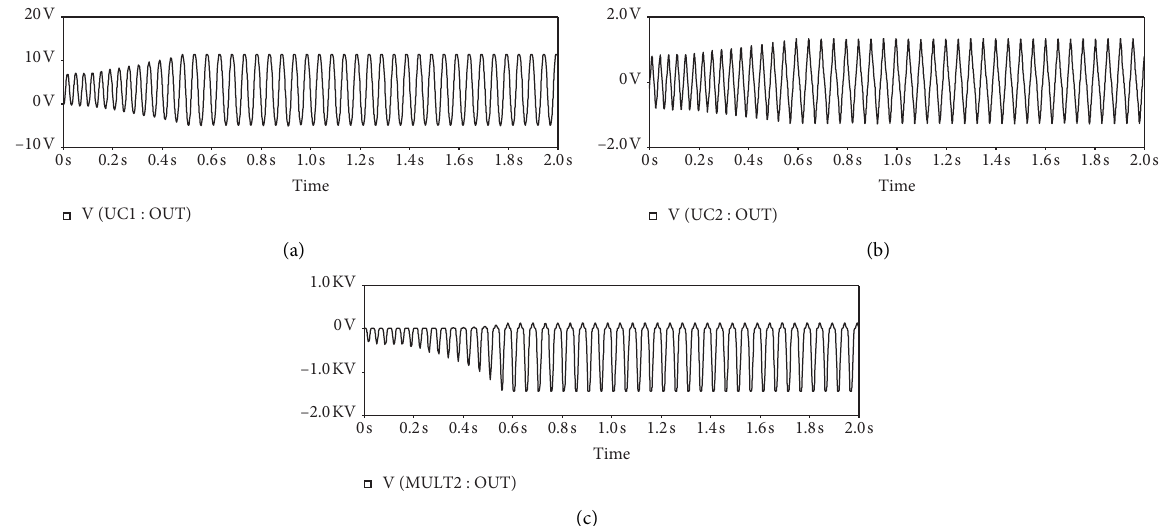
Figure 6: Output voltages of (a) amplifier with capacitor C C � 100nF , C 1